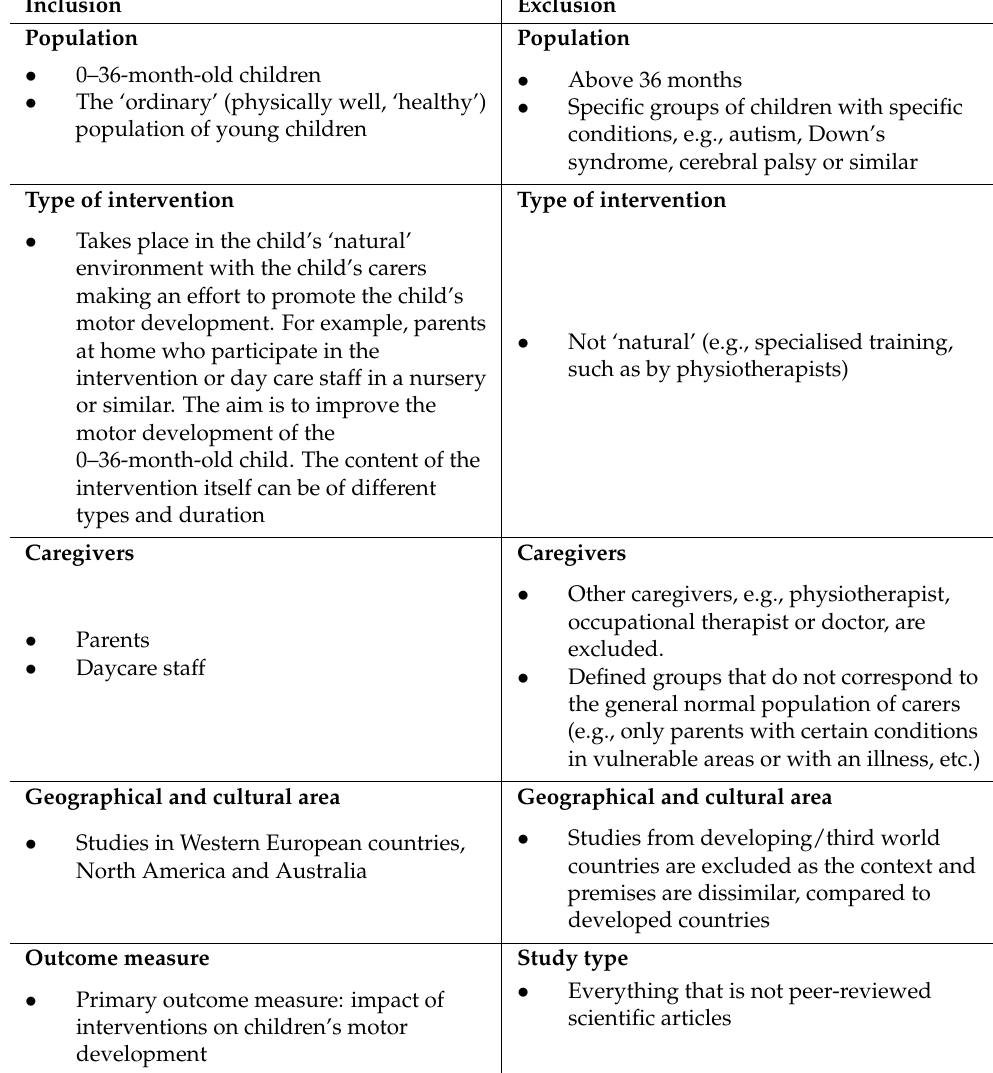
Table 1. Inclusion and exclusion criteria of the